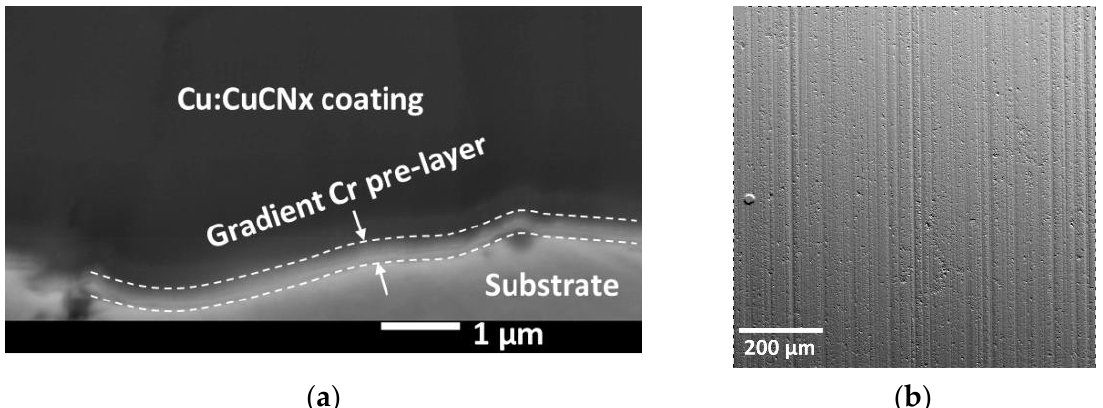
Figure 5. SEM cross-section of Cu:CuCN x coating.